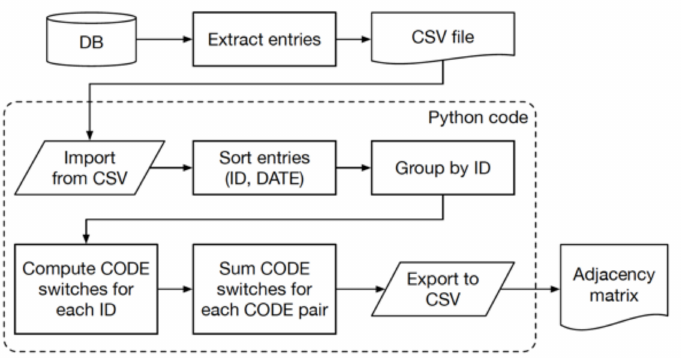
Figure A1. Algorithm